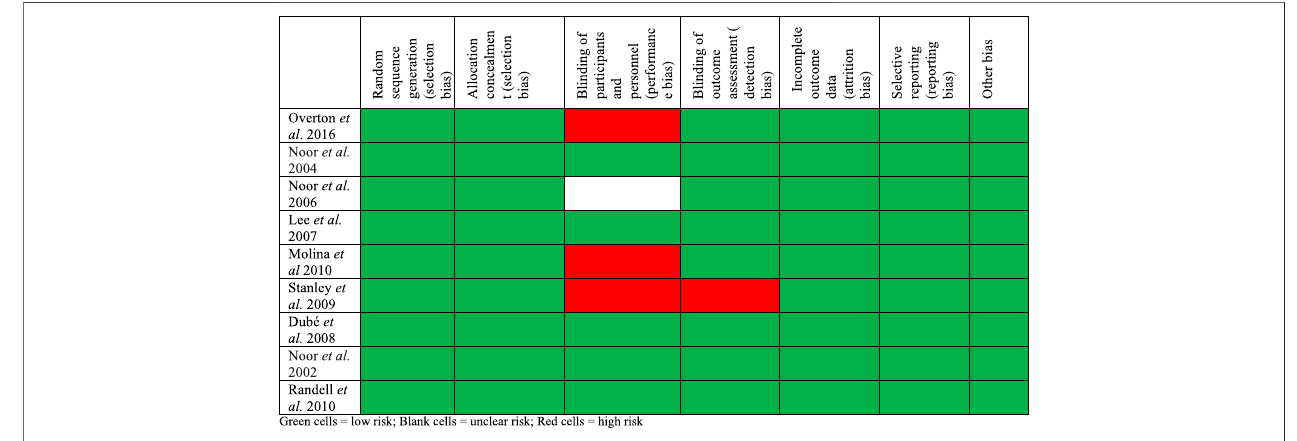
FIGURE 2 | Risk of bias summary: review authors ’ judgments about each ’ risk of bias ’ item for included trials.